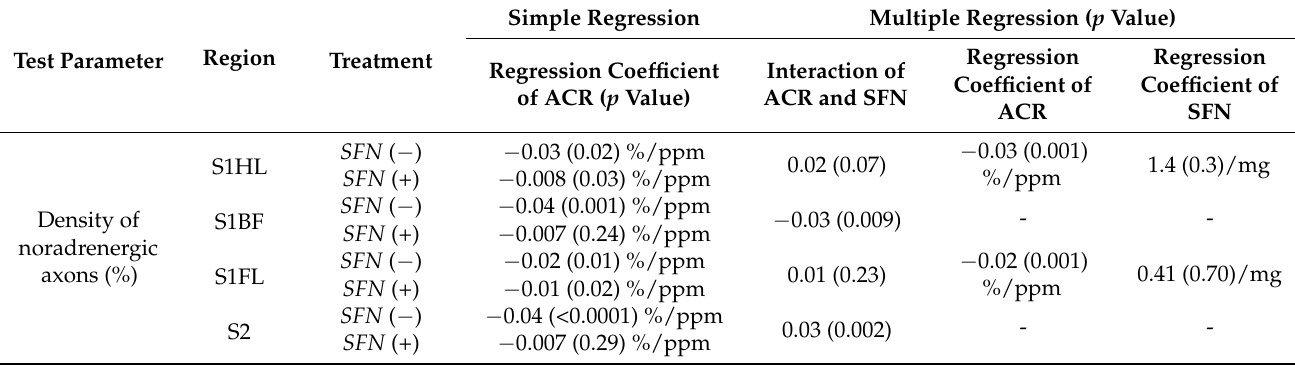
Figure 5. Representative photomicrographs ( A ) and density ( B ) of noradrenaline transporter (NAT)-immunoreactive axons in the secondary somatosensory cortex (S2) of mice following exposure to acrylamide and treatment with sulforaphane. Data are mean ± SD. ** p < 0.01, *** p < 0.001, compared to the corresponding control (by ANOVA followed by Dunnett’s multiple comparison). Scale bars = 40 µm; n = 4. Table 2. Results of regression analysis of the effects of acrylamide and sulforaphane co-treatment on the density of noradrenergic axons in primary and secondary somatosensory cortex.